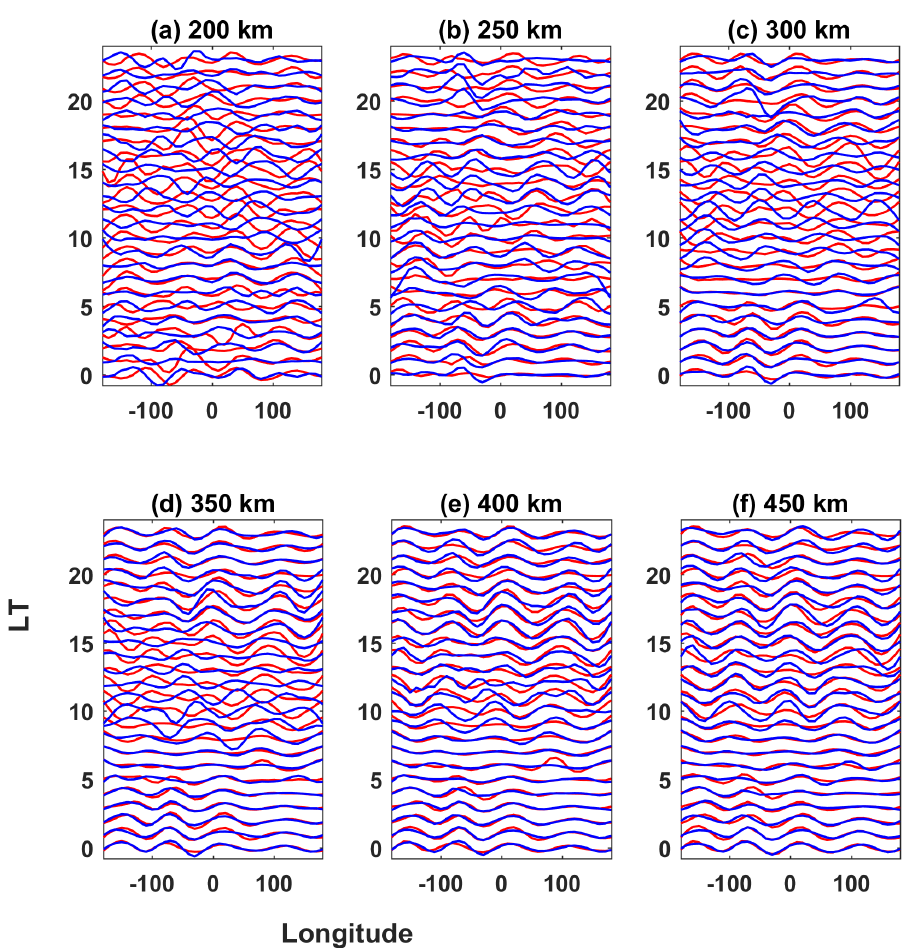
Figure 8. ( a – f ) Local-time variation of WN4 component related to EIA crest (red) and trough (blue) regions at 6 different height levels.